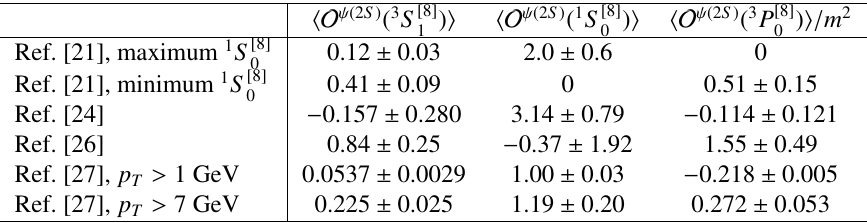
Table 2. Phenomenological determinations of ψ (2 S ) color-octet matrix elements in units of 10 − 2 GeV 3 from refs. [21, 24, 26, 27]. In ref. [21], only two linear combinations of the three matrix elements are determined, and the maximum ranges of the matrix elements are obtained from maximizing and minimizing ⟨O ψ (2 S ) ( 1 S [8] ) ⟩ under the assumption made in ref. [21] that the matrix elements are positive 0 definite. Refs. [24, 26, 27] provide covariance matrices from which the correlations in the uncertainties can be obtained. The pNRQCD result from ref. [26] is from the analysis with p T larger than 5 times the heavy quarkonium mass. Ref. [27] also provides results for fits including polarized cross sections, which are consistent with the results from including only polarization-summed cross sections within